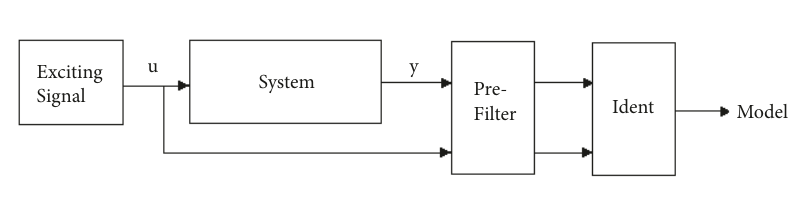
Figure 1: Identification using